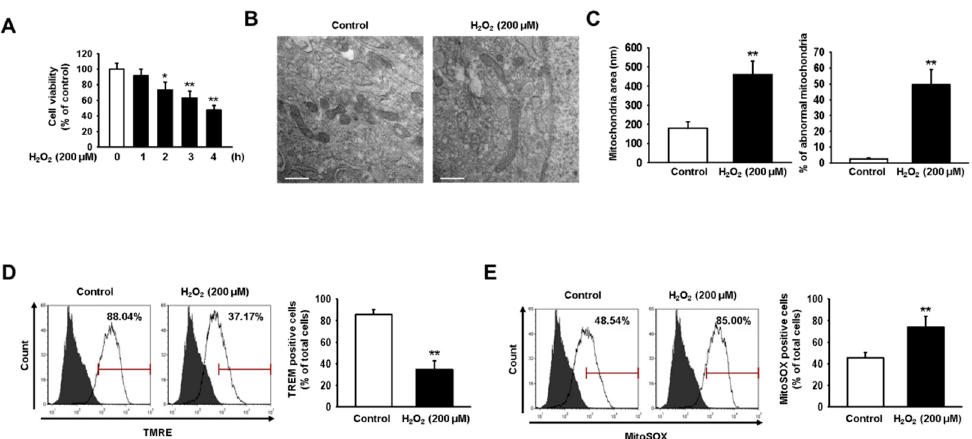
Figure 1. H 2 O 2 -induced oxidative stress reduces human mesenchymal stem cell (hMSC) viability by inducing mitochondrial dysfunction. ( A ) MTT assay was used to assess the viability of hMSCs treated with 200 µ M H 2 O 2 and that of untreated hMSCs. Values represent the mean ± SEM. * p < 0.05 or ** p < 0.01 vs. control. ( B ) Transmission electron microscopy (TEM) was used to evaluate mitochondrial morphology in hMSCs treated for 24 h with H 2 O 2 (200 µ M) and in untreated hMSCs. Scale bar = 500 nm. ( C ) Quantitative analyses of morphometric data and percentages of abnormal mitochondria showing swelling and severely disrupted cristae. Images were obtained using TEM. Values represent the mean ± SEM. ** p < 0.01 vs. control. ( D ) Tetramethylrhodamine, ethyl ester (TMRE)-positive hMSCs, with and without treatment using H 2 O 2 (200 µ M), were quantified via fluorescence-activated cell sorting (FACS). Values represent the mean ± SEM. ** p < 0.01 vs. control. ( E ) MitoSOX-positive hMSCs with and without treatment using H 2 O 2 (200 µ M) were quantified via FACS. Values represent the mean ± SEM. ** p < 0.01 vs. control.